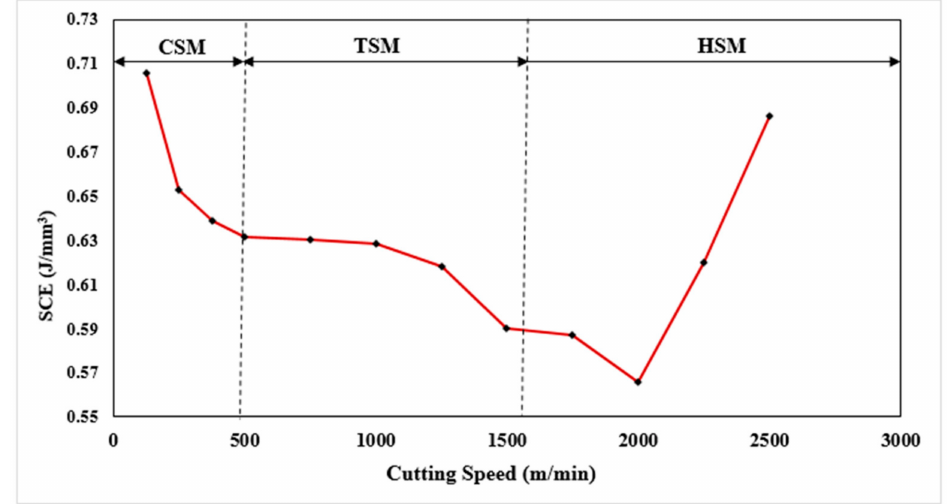
Figure 11. Effect of cutting speed on SCE.